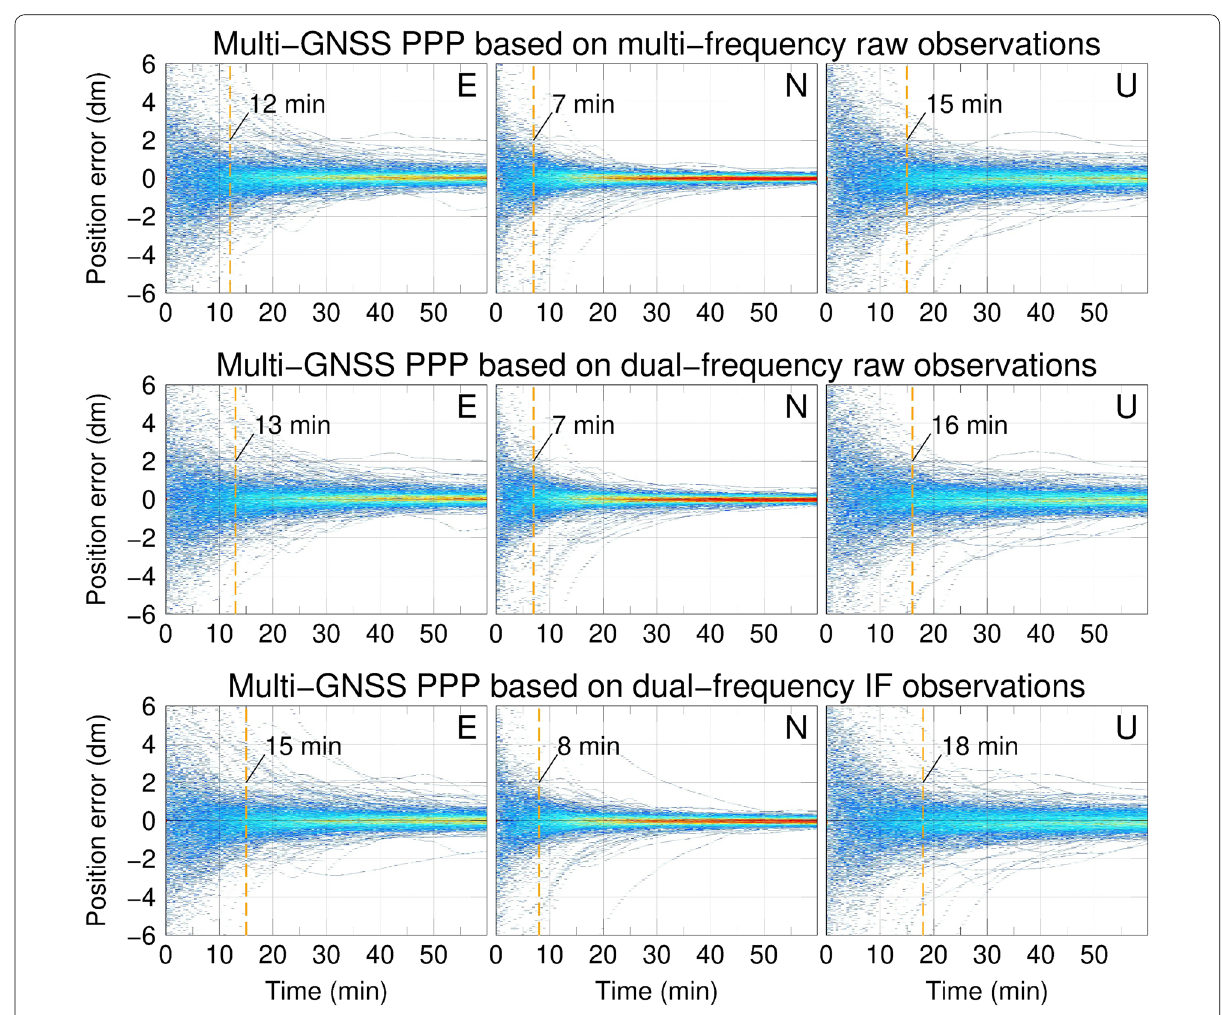
Fig. 8 Time series of the positioning error for Multi-GNSS PPP for the 96 stations in GPS week